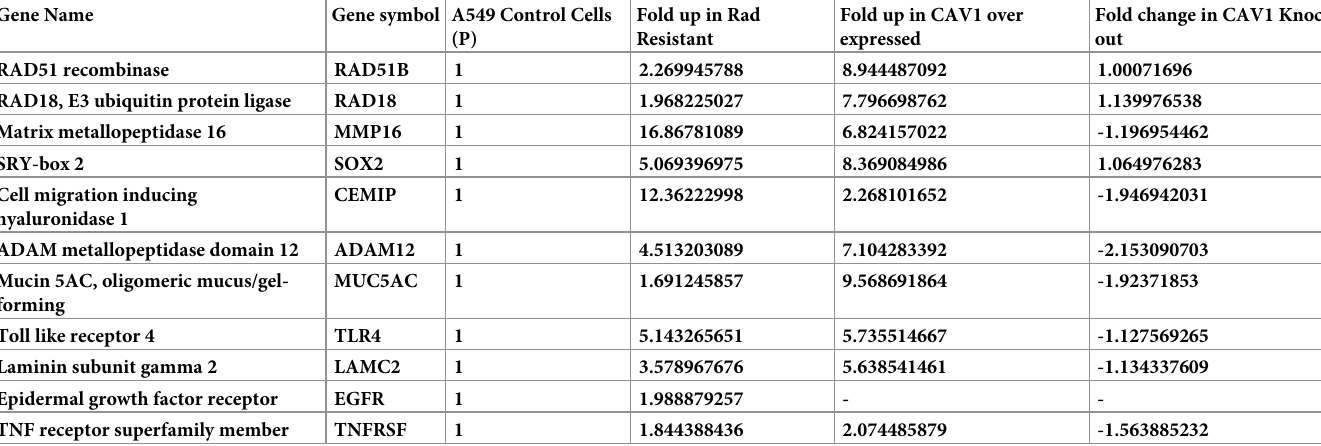
Table 1. Comparative gene expression (fold changes) profile analysis of genes in A549 parental, radioresistant, CAV-1 overexpressed and CAV-1 KO cells. Gene